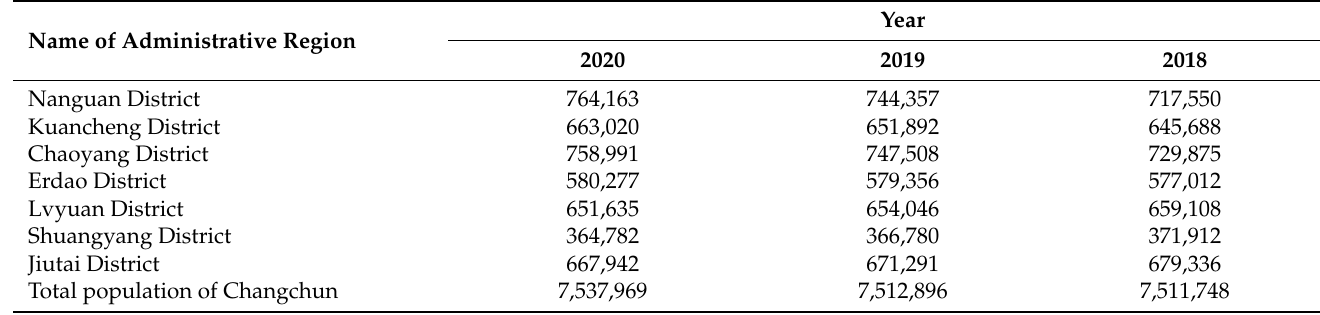
Table A1. Total population of each district in Region M.